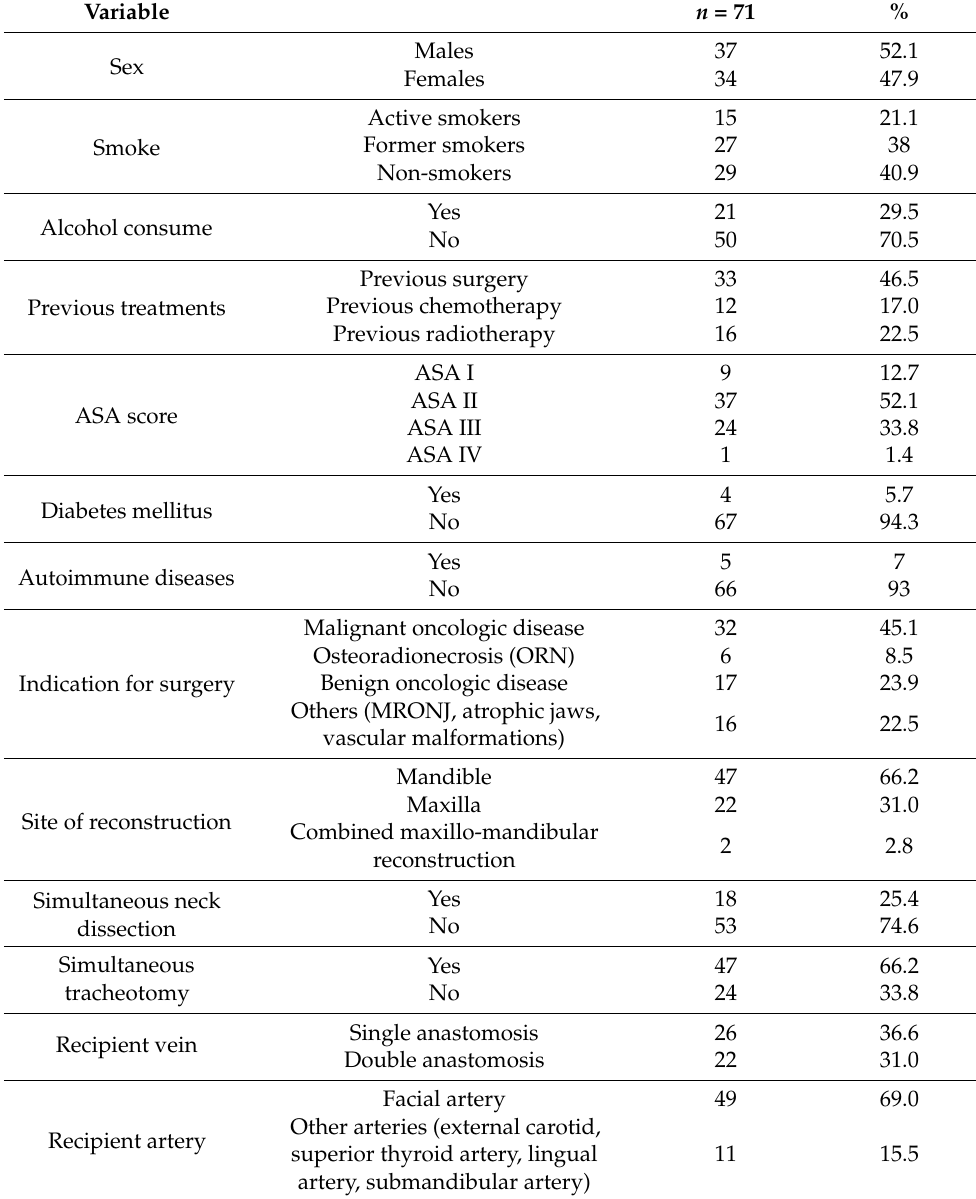
Table 1. Demographic, clinical and surgical data collected. ASA = American Society of Anesthesiolo- gists; MRONJ = Medication-Related Osteo-Necrosis of the